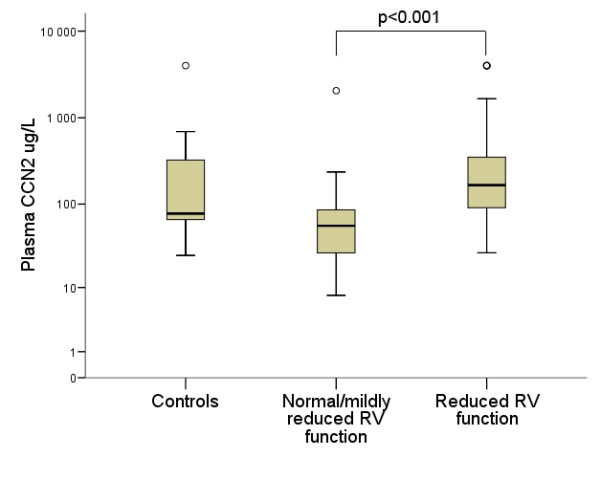
Relationship between plasma connective tissue growth factor and right ventricular function. Box plot demonstrating the relationship between plasma connective tissue growth factor (CCN2) levels and right ventricular (RV) function. Median, interquartile ranges, and maximum and minimum values are shown. Due to the presence of extreme outliers, plasma CCN2 levels are plotted on the y-axis using a logarithmic (log10) scale. Plasma CCN2 levels (μg/L) are significantly elevated in the patients with reduced RV function (strain > -20%), (Mann-Whitney U test, p < 0.001).